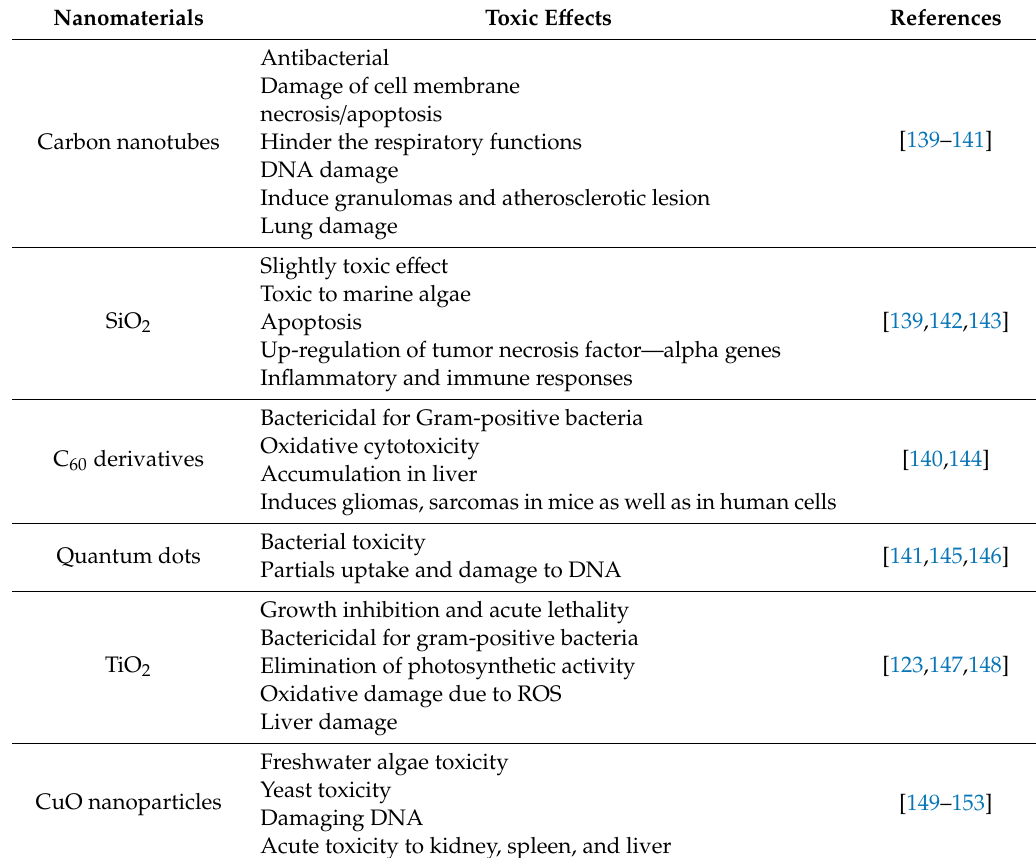
Table 2. The toxicity of the various